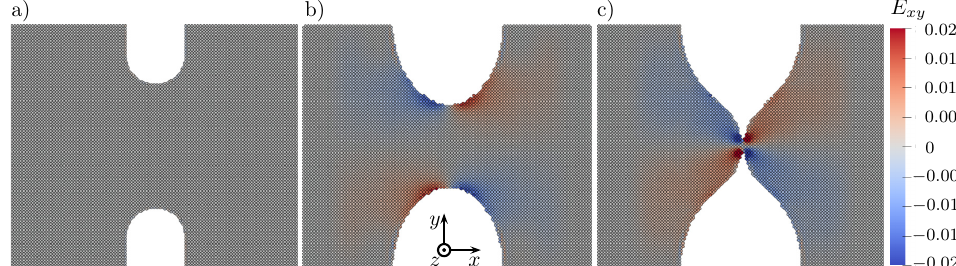
Figure 7. Discrete Green strain component ˆ E xy , evaluated by Equation (13) based on the discrete deformation gradient in Equation (21), at ( a ) the initial state, ( b ) an intermediate state and ( c ) the final